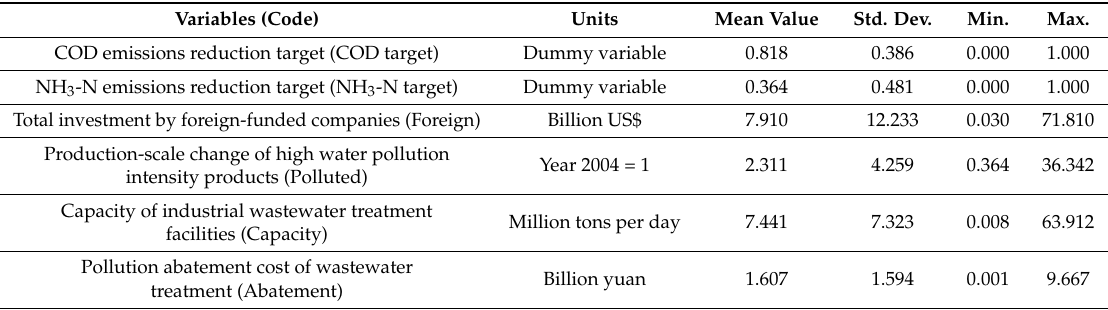
Table 2. Descriptions of variables used in the determinant